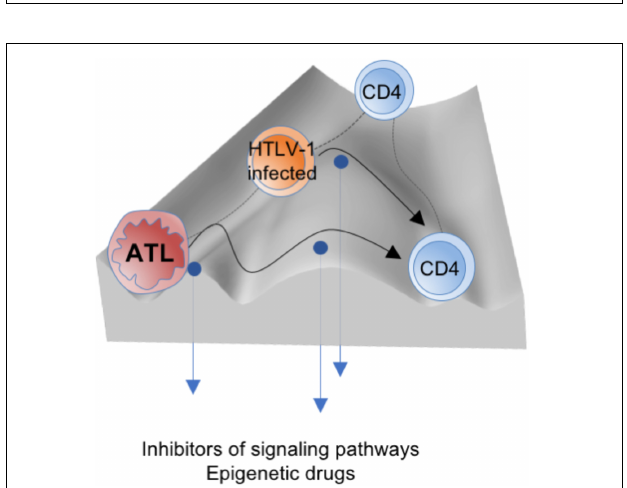
FIGURE 3 | The mechanism-based medicines such as epigenetic drugs and inhibitors of signaling pathways could reprogram the fate of HTLV-1-infected cells (conceptualized as a reduction or elevation of the walls (blue arrows), which promote crossing or bypassing within the epigenetic landscape (black curved arrows) into the normal